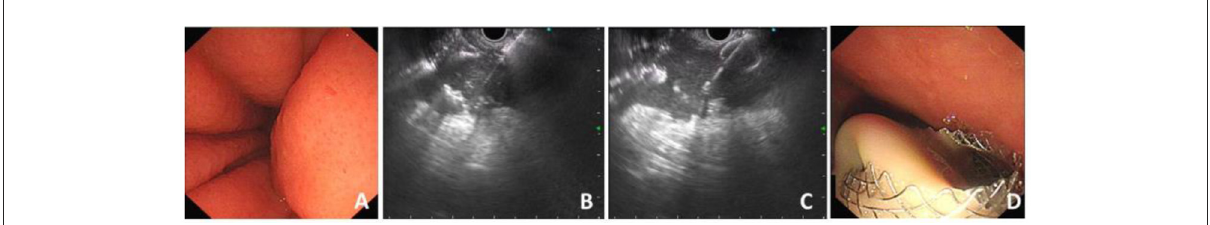
FIGURE1 Procedure process of EC-LAMS for drainage of PFC. (A) Endoscopic view of compression of the posterior wall of the stomach. (B) Puncture of PFC with the electrocautery system under the guidance of EUS. (C) Release of the distal flange. (D) A large amount of necrotic fluid flows out through the deployed